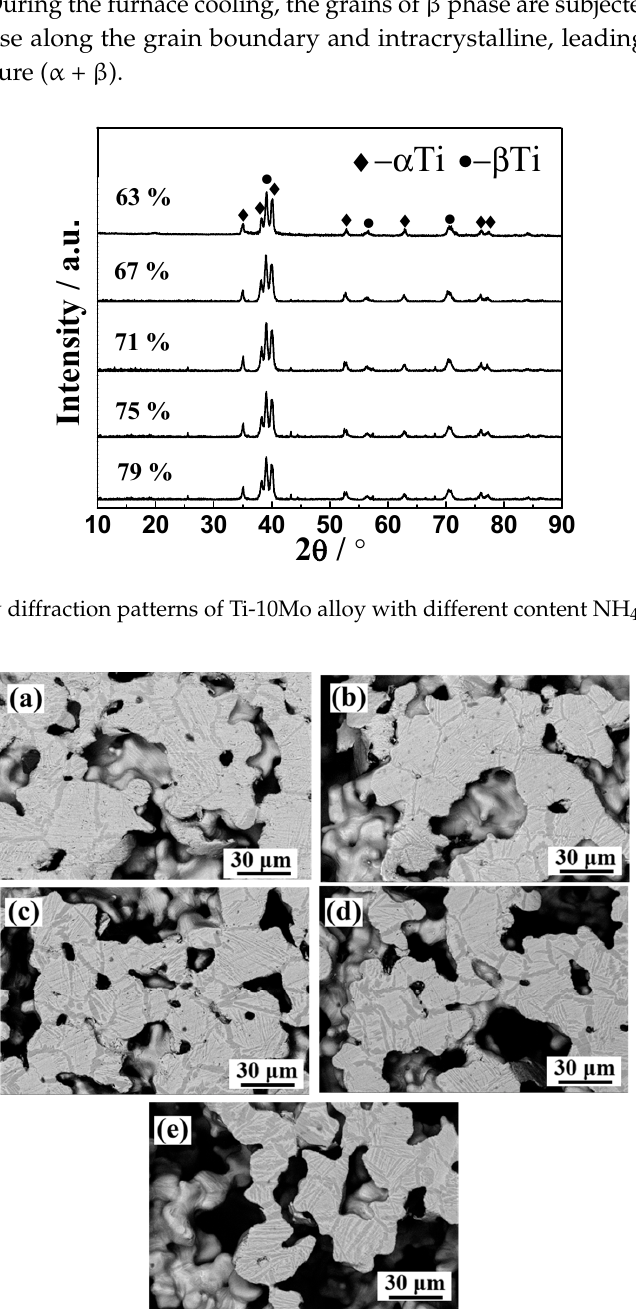
Figure 5. Scanning electron back scattering morphologies of porous Ti-10Mo alloys with different content NH 4 HCO 3 added: ( a ) 63%; ( b ) 67%; ( c ) 71%; ( d ) 75%; ( e ) 79%.